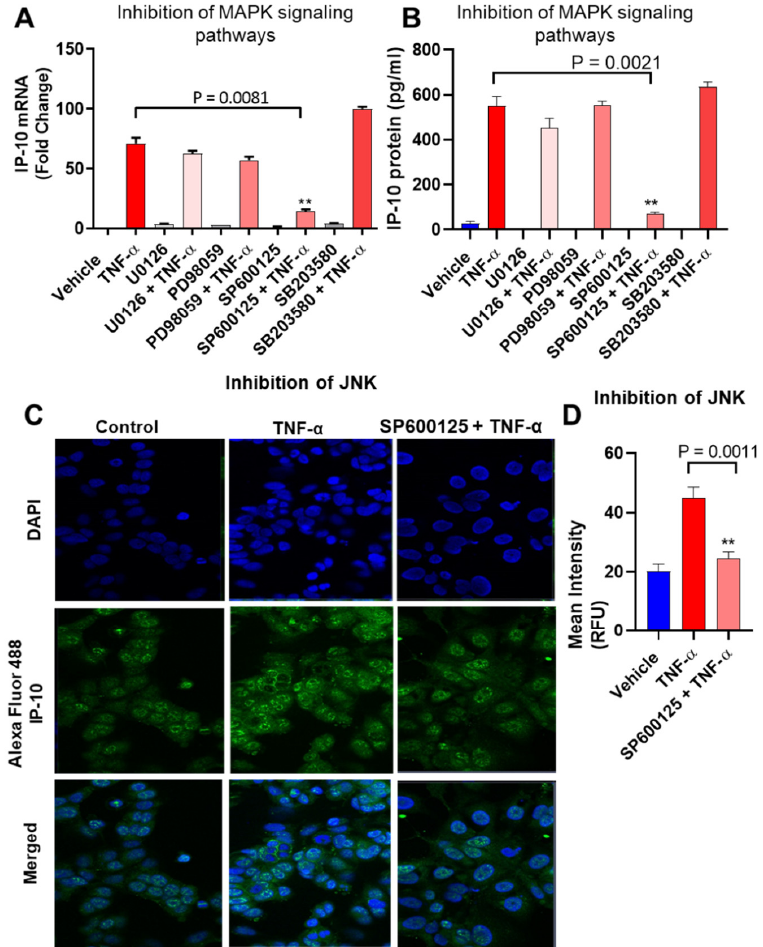
Figure 2. TNF-α-induced IP-10 expression is suppressed by inhibiting the JNK signaling pathway. ( A , B ). MCF-7 cells were pretreated for 1 h with inhibitors of MEK1/2 (U0126; 10 μM), ERK1/2 (PD98059; μM), JNK (SP600125; 10 μM), and p38 (SB203580; 10 μM) and then incubated with TNF-α for 24 hrs. Cells and culture media were collected. IP-10 mRNA and protein expression were determined using real-time RT-PCR and ELISA, respectively. ( C ) MCF-7cells were pretreated with SP600125 (10 μM) for 1 h, followed by TNF-α (20 ng/mL) treatment for 24 h. MCF-7 cells were then immune-stained for confocal microscopy, as described in Materials and Methods. IP-10 expression is shown by green fluorescence (Alexa Flour 488), whereas nuclei are stained blue with DAPI (original magnification 40×). ( D ) Relative fluorescence intensity of IP-10 expression was determined from random regions of the images. All data are expressed as mean ± SEM ( n = 3). ** p < 0.01.